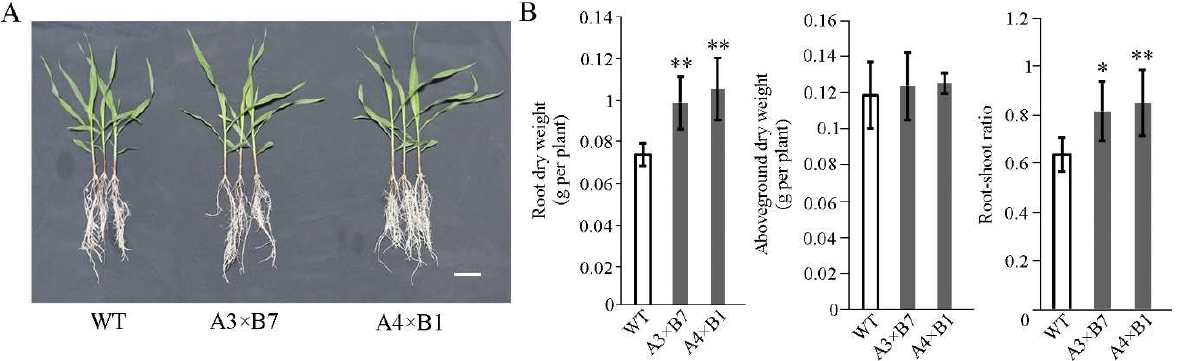
Figure 3. Analysis of root systems in transgenic and WT maize seedlings. ( A ) Representative photographs of WT and transgenic maize root systems. Bar = 5 cm. ( B ) Statistical analysis of root dry weight, aerial tissue dry weight, and root-shoot ratios of WT and transgenic maize under full irrigation ( n = 6 plants per line). The experiment was conducted three times. Data are average of three independent tests ± s.d. (* p < 0.05, ** p < 0.01; two-sided t -test).